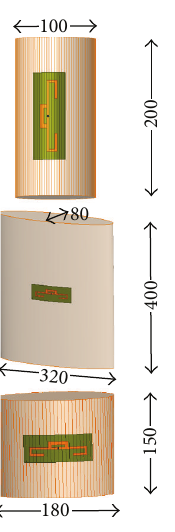
Figure 10: Homogeneous simulation models for (up to down): the upper arm, chest, and head cases. Dimensions are in mm. The same model dimensions are used for both volunteer